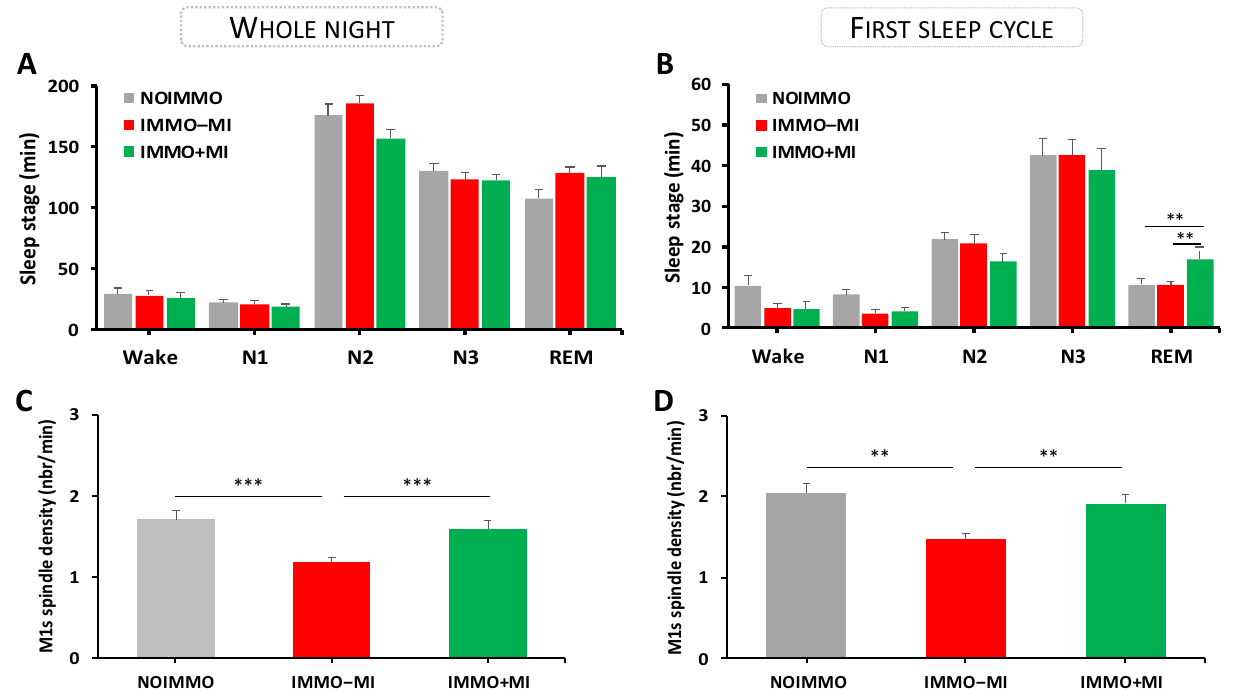
Figure 4. Sleep architecture and spindles density over both M1s during the whole night and the first sleep cycle after each condition (NOIMMO, IMMO−MI, IMMO+MI). ( A ) Sleep stage duration (min) for each condition during the whole night, and ( B ) during the first sleep stage. REM sleep duration increased in the IMMO+MI condition relative to NOIMMO and IMMO−MI. ( C ) Reduced spindle density (nbr/min) over the left and